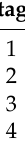
Table 2. Forest growth change (%) due to climate change.